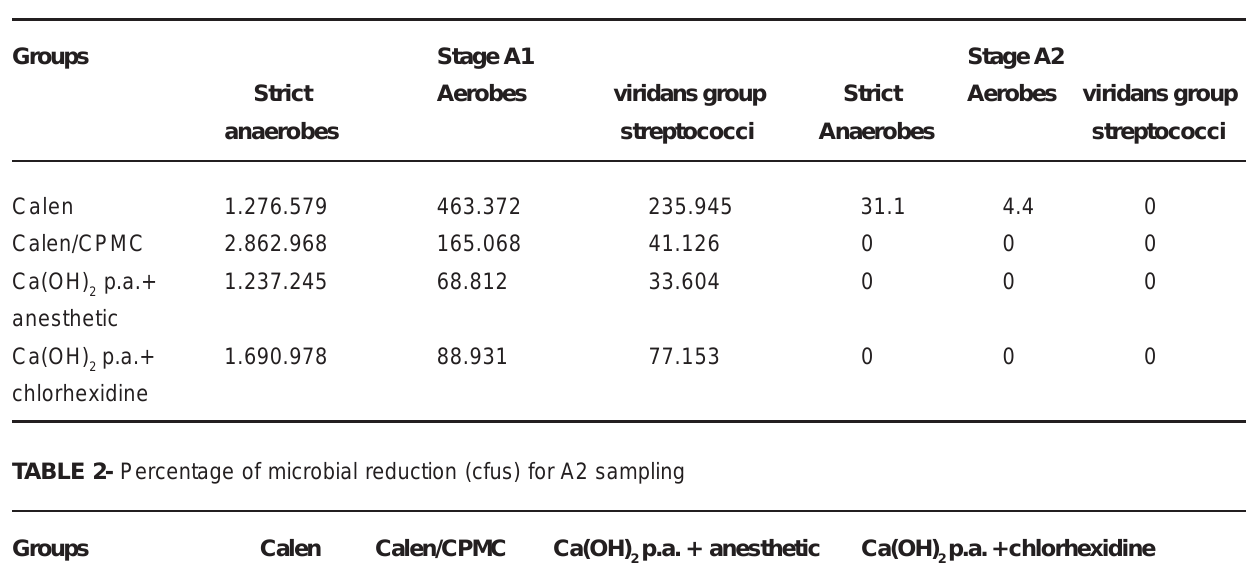
TABLE 1- Cfus means of microorganisms before endodontic treatment (A1) and 4 days after the removal of the calcium hydroxide-based pastes (A2)